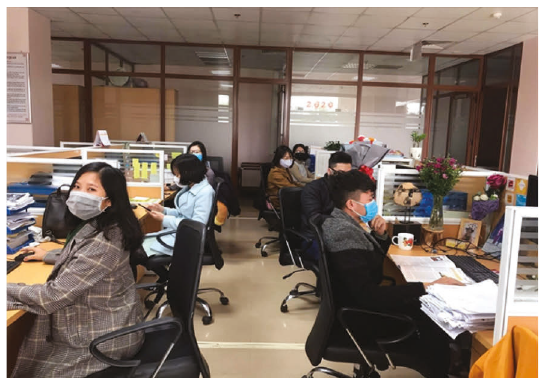
Figure 1: Employees wearing masks when working at the office (source: from the Internet).